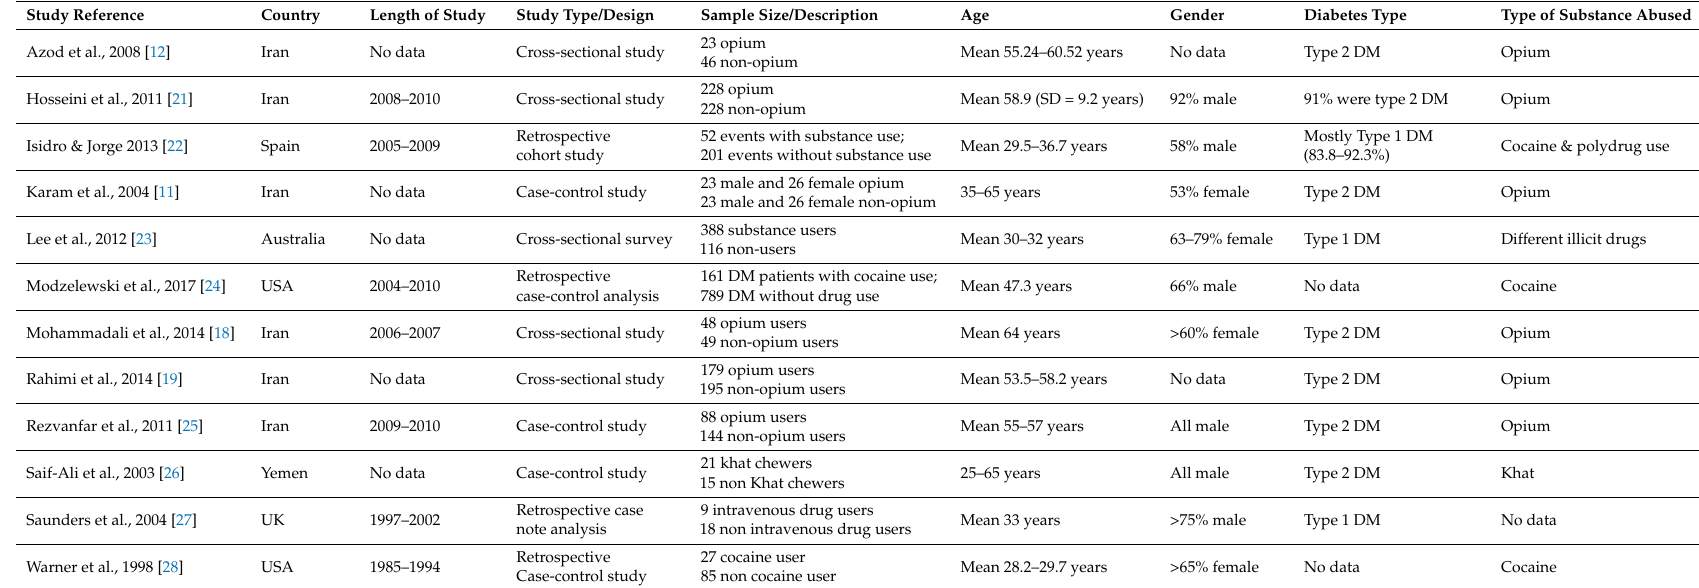
Table 2. Characteristics of the articles included in this review ( N =